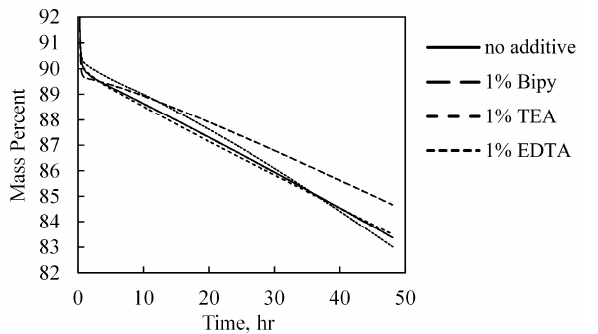
Figure 3. Absorption spectra of ( a ) Bipy:Cu and ( b ) Bipy:Fe samples of different mole ratios in nitric acid.